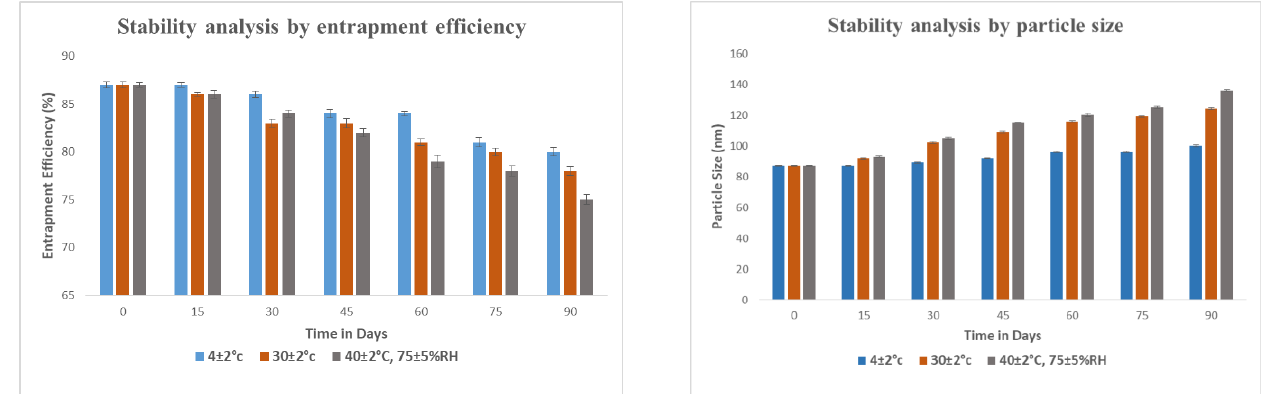
Figure 14. Graphical representation of stability study of methotrexate-loaded nanoemulsion accord- ing to particle size and entrapment efficiency.